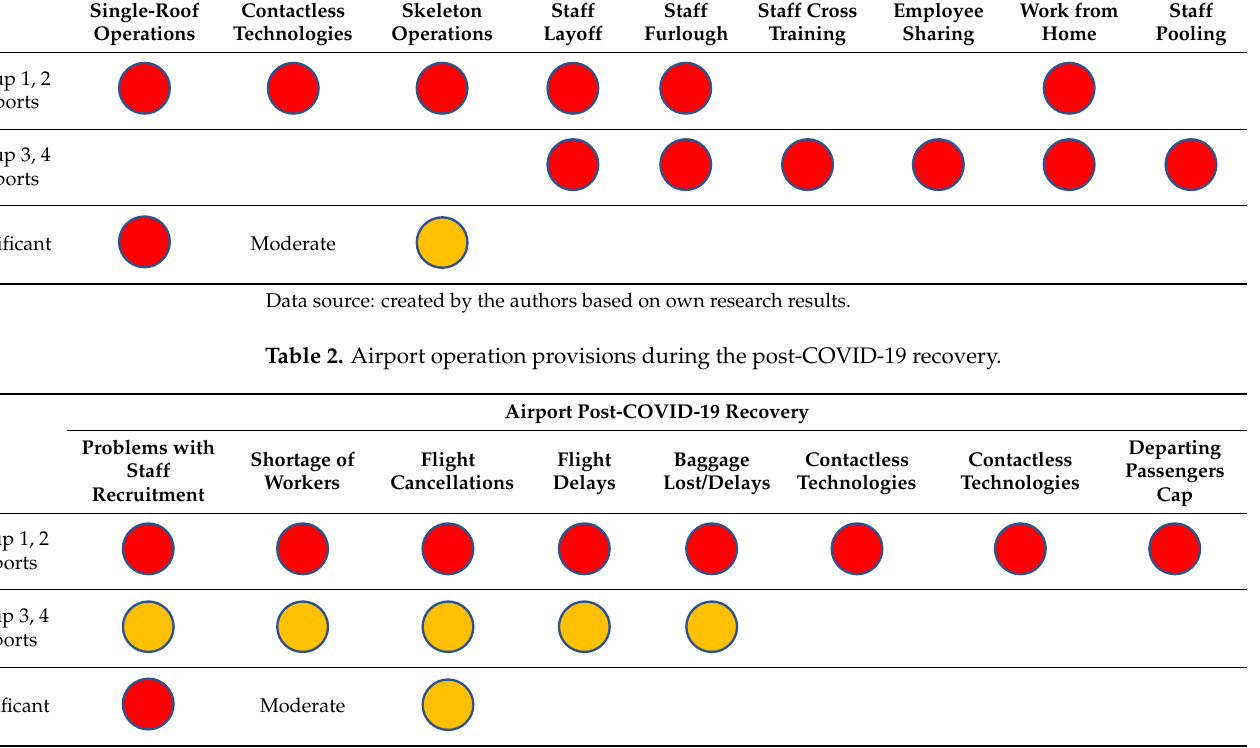
Table 1. Airport operation provisions during COVID-19.